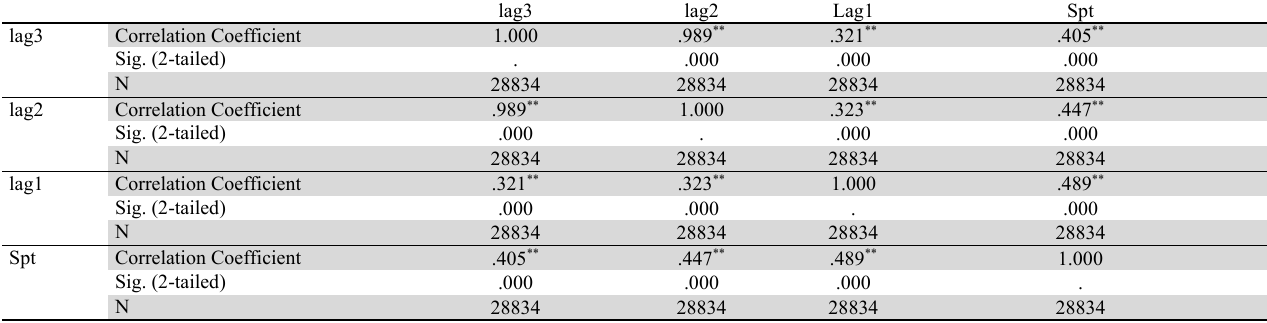
Spearman correlation coefficient test